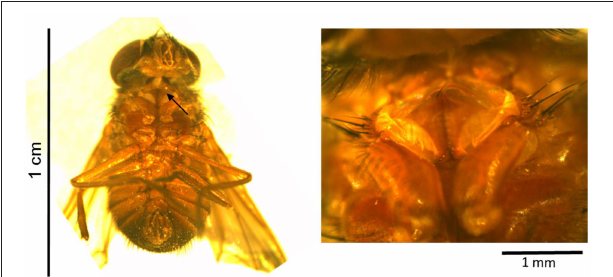
FIGURE 5 | Habitus (left) and hearing organ (right) of a female tachinid fly of an unknown Tachinid species homing in on M. elongata males. Arrow indicates the position of the fly’s ear. This fly belongs to the tribe Ormiini of an unknown genus (potentially Therobia , Phasioormia, or Homotrixa ).